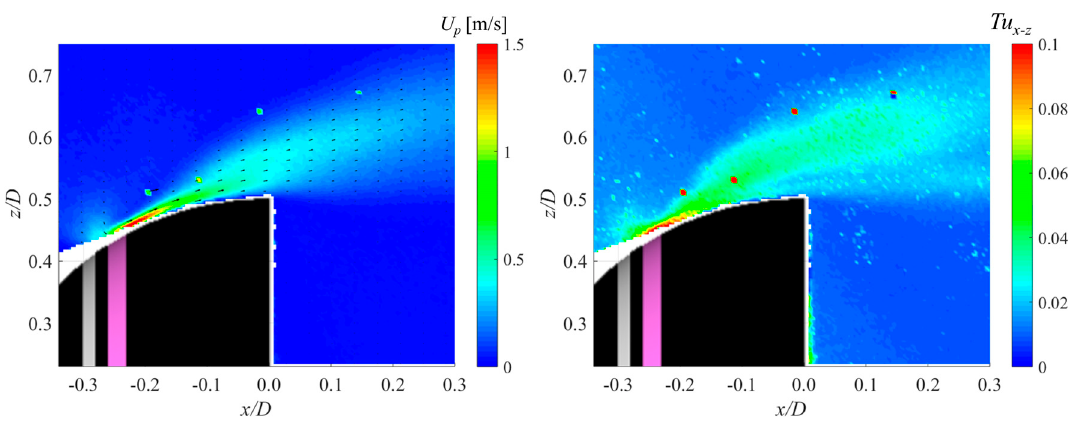
Figure 8. Time-averaged velocity and turbulent intensity distributions under quiescent flow condition in the x – z cross section ( y / D = 0.0): velocity magnitude ( U p , left ) and turbulent level ( Tu x-z , right ).